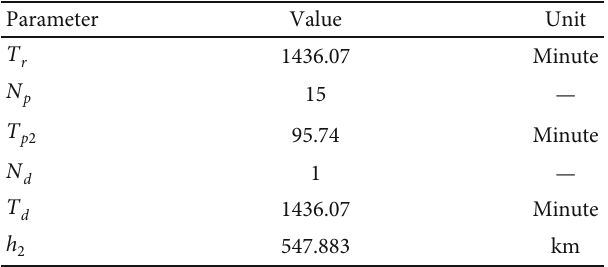
Table 1: Parameters of the fi nal repeating ground track orbit.